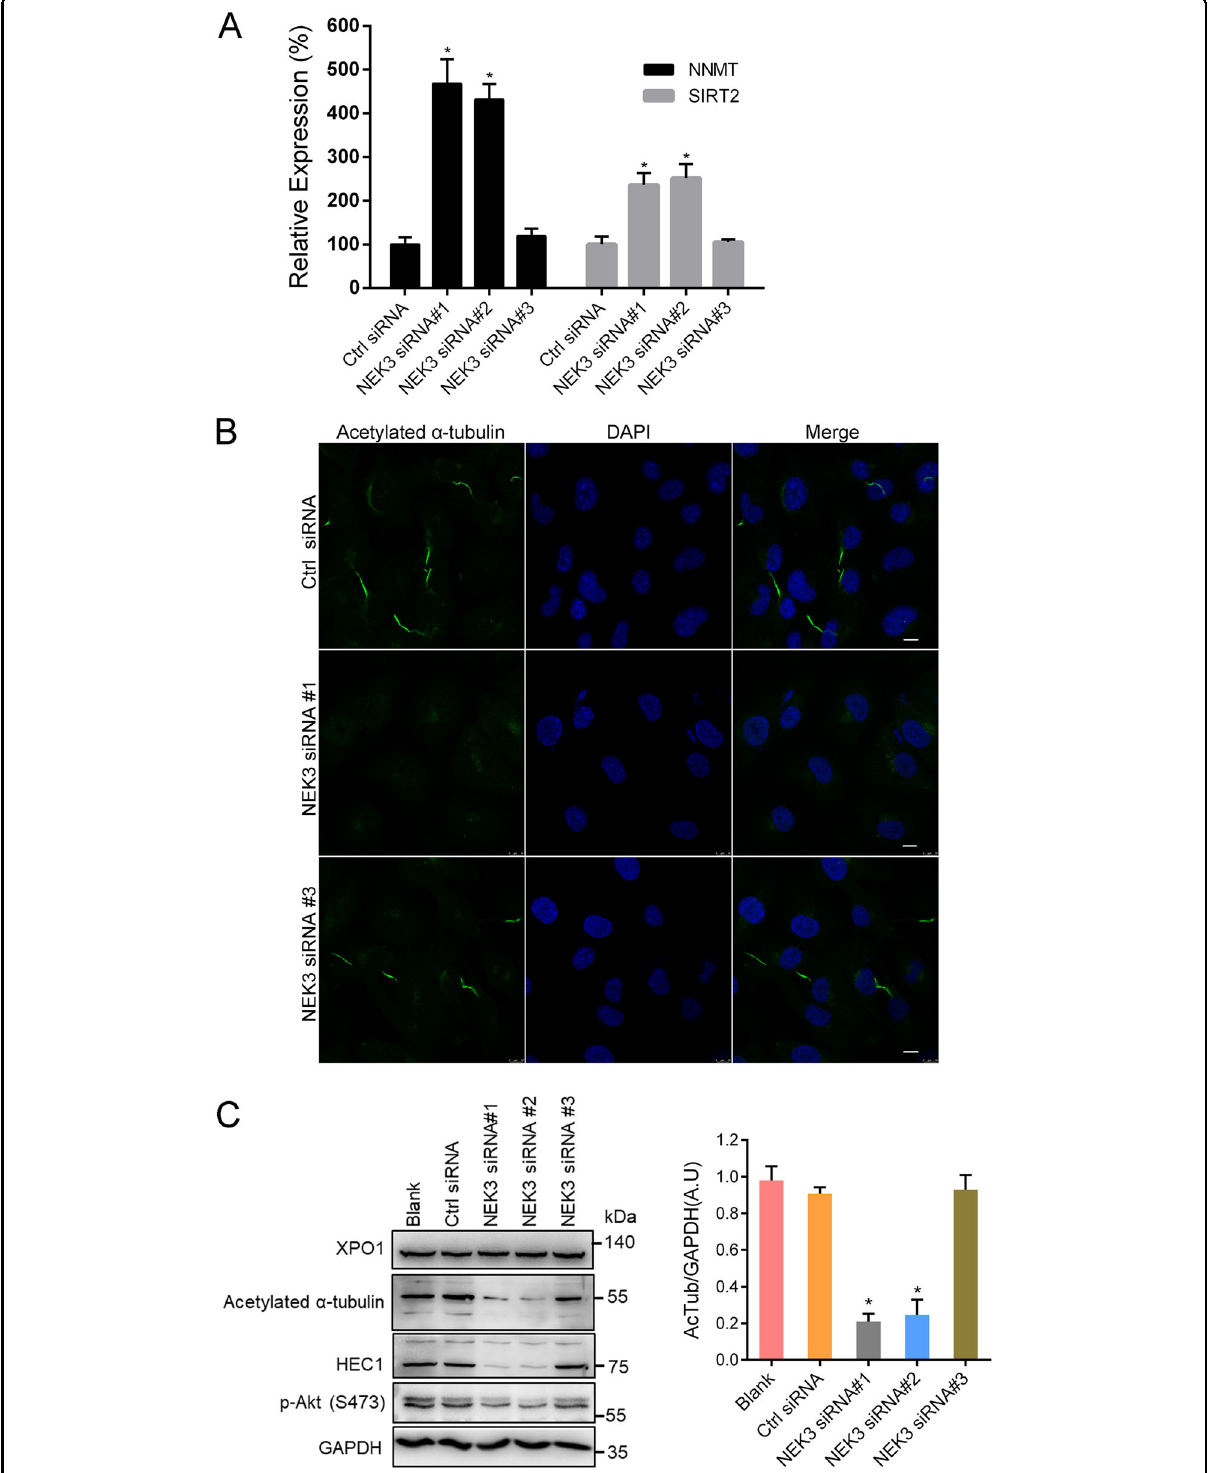
Fig. 4 NEK3 de fi ciency promotes expression of NNMT and SIRT2, and deacetylates α -tubulin. a Upregulation of NNMT and SIRT2 in NEK3- silenced cells were validated by real-time quantitative PCR. * P value <0.05 (Mann – Whitney U test, n = 4). b Immuno fl uorescence assay by staining acetylated α -tubulin antibody using a confocal microscope in RPE cells transfected with Ctrl siRNA, NEK3 siRNA#1 or ineffective siRNA#3 in vitro. Scale bar, 10 μ m. c Protein expression of acetylated- ɑ -tubulin, HEC1, XPO1, p-AKT(S473) in NEK3-silenced RPE cells was evaluated by western blot. GAPDH served as a loading control. Right panel: Quanti fi cation data of acetylated- ɑ -tubulin (AcTub) protein level when normalized against GAPDH. * p value <0.05 (Mann – Whitney U test). AU arbitrary units. Representative image from three independent experiments was